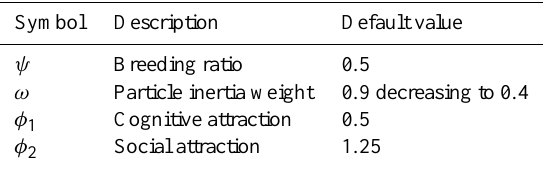
Table 1. Default values of the parameters that control the PSO-GA u